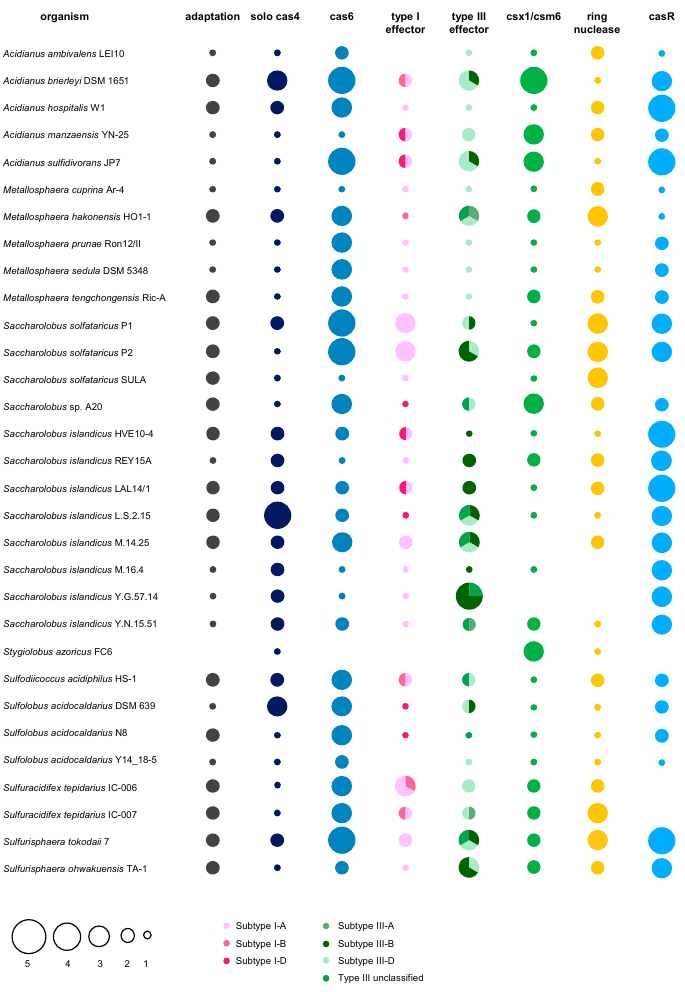
Figure 4. Distribution of CRISPR-Cas (sub) types and accessory genes in Sulfolobales genomes. The bubble plot shows the distribution and abundance of genes encoding proteins and protein complexes partaking in the CRISPR-Cas immune response in Sulfolobales genomes. The abundances of adaptation cassettes ( cas1-cas2 , frequently also cas4 ), cas6 (crRNA processing) and CRISPR-Cas effectors (interference) are depicted by size; abundances of the different subtypes of CRISPR-Cas effectors are indicated by different color shadings. Some adaptation cassettes contain either a cas1 or cas2 gene with internal stop codon or frameshift, highlighted in Supplementary Table S1. Additionally, abundances of solo cas4 (not encoded within 15 ORFs with respect to other adaptation genes) and accessory genes csx1 / csm6 , crn (ring nuclease), casR (specific transcriptional regulator) are illustrated by bubbles in corresponding sizes. In cases with great overlap between di ff erent strains of the same species, only one genome is shown as a representative for all similar strains (e.g., S. solfataricus SULA and derivative strains). The analysis is based on data published in [19], and / or obtained by using programs CRISPRminer (version 1, [258]), CRISPRCasFinder (version CRISPR-Cas ++ 1.1.2, [241]), and BLAST ([262,263]); BLAST analysis of Crn and Csx1 was performed based on amino acid sequences of the respective biochemically and structurally characterized proteins